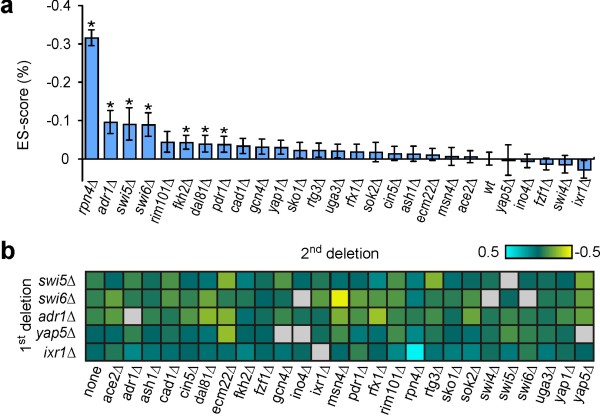
Analysis of environmental sensitivity scores. (a) Mean ES-scores for the wildtype (wt) and the 26 single deletion mutants. Asterisks indicate strains with statistically significant environmental sensitivity (P < 0.05). (b) Examples of variation in ES-scores for selected deletion mutants following the introduction of a second TF deletion. Grey squares indicate double mutants not assayed.